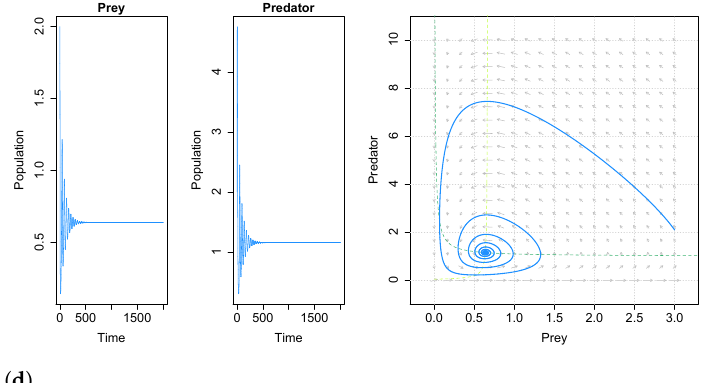
Figure 10. Solutions and phase portraits of system (40) with parameters r = 0.1, a = 0.1, b = 0.3 and n = 0.2. ( a ) Dynamic behavior with no immigration. ( b ) Dynamic behavior with prey immigration ( c 1 ( x ) = 0.01, c 2 ( y ) = 0). ( c ) Dynamic behavior with predator immigration ( c 1 ( x ) = 0, c 2 ( y ) =